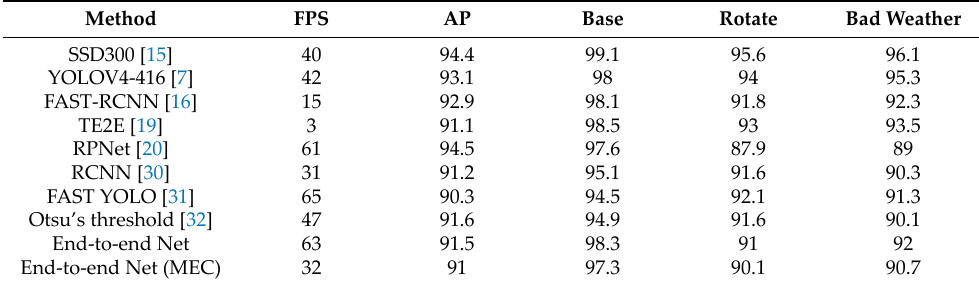
Table 6. Comparative accuracy results of object detection.